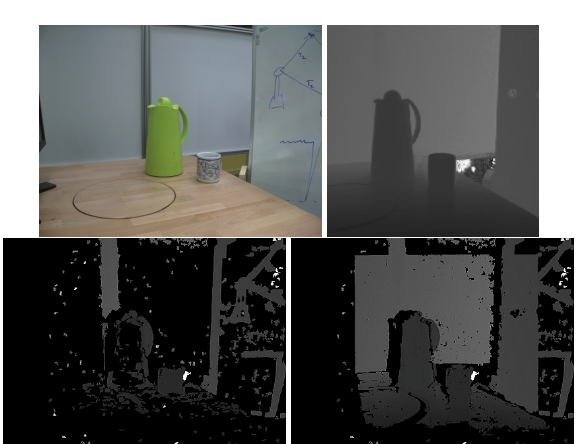
Figure 5. Original recordings of the left color camera (top left) and the time- of-flight sensor (top right) as well as disparity maps obtained from stereo vision (bottom left) and from sensor fusion with time-of-flight data propagation (bottom right).